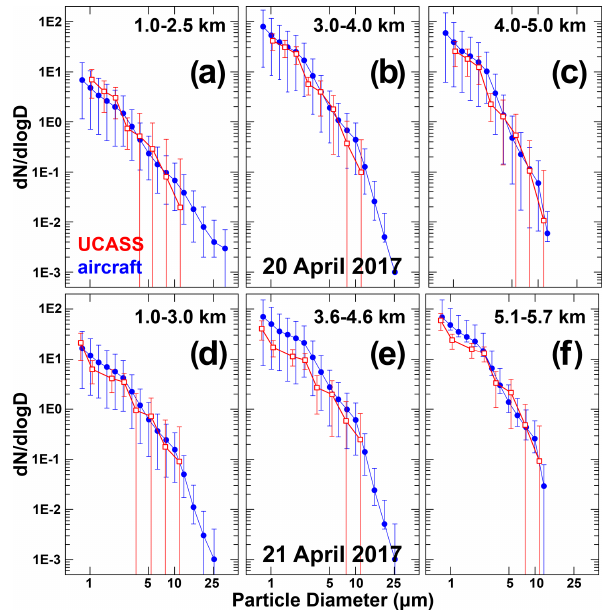
Figure 6. Particle number size distribution observed by UCASS (red) and with the CAPS instrument aboard the Falcon aircraft (blue) on 20 ( a–c , launch 1) and 21 April 2017 ( d–f , launch 3) for the height layers marked in Fig. 4. Error bars refer to the standard deviation of the